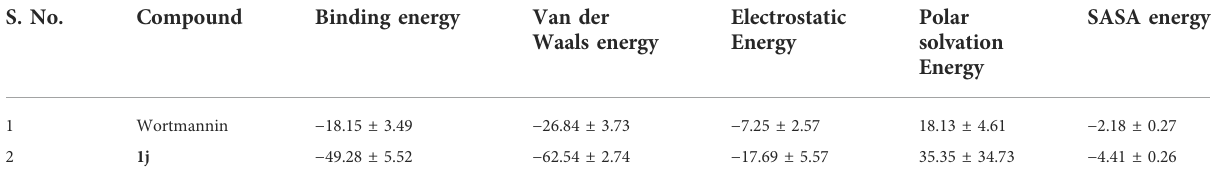
TABLE 3 The binding free energy of the Wortmannin and 1j complex calculated using MM-PBSA analysis. S.